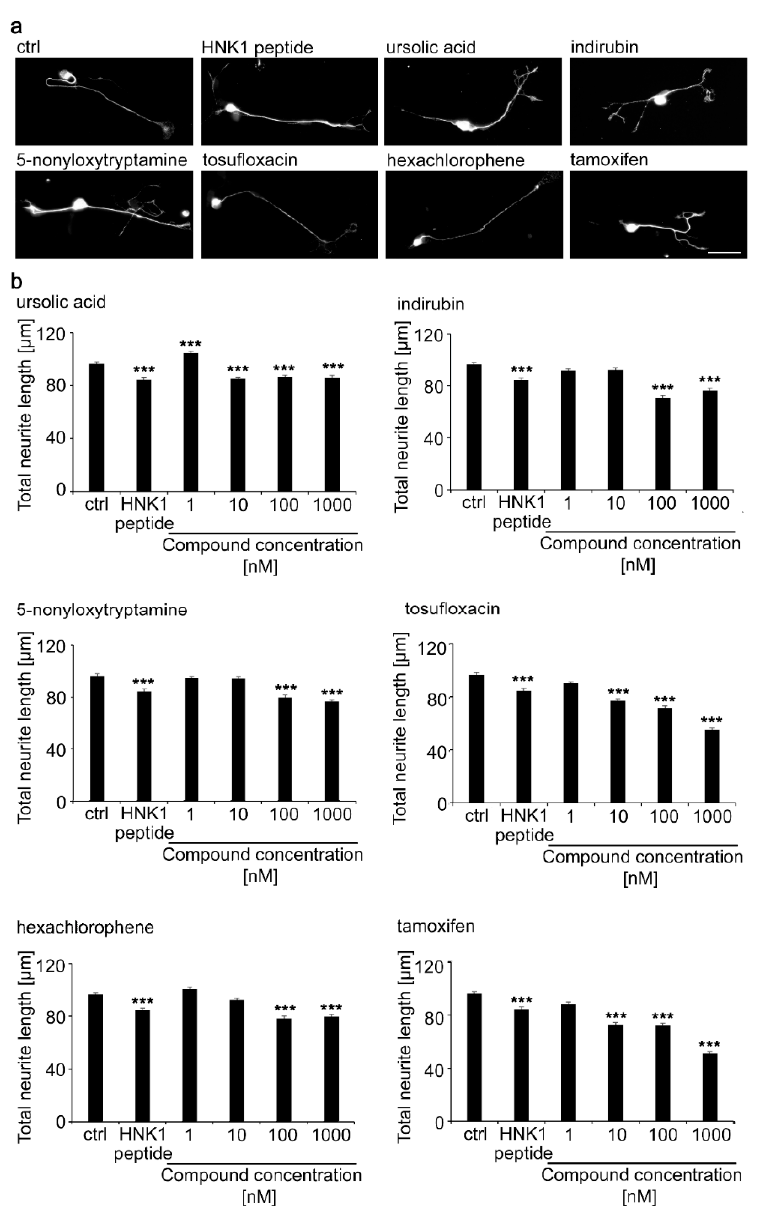
Figure 5. Neurite length of dorsal root ganglion neurons treated with different concentrations of HNK1 mimetics. Cultures were treated with different concentrations of HNK1 mimetics for 24 h. The